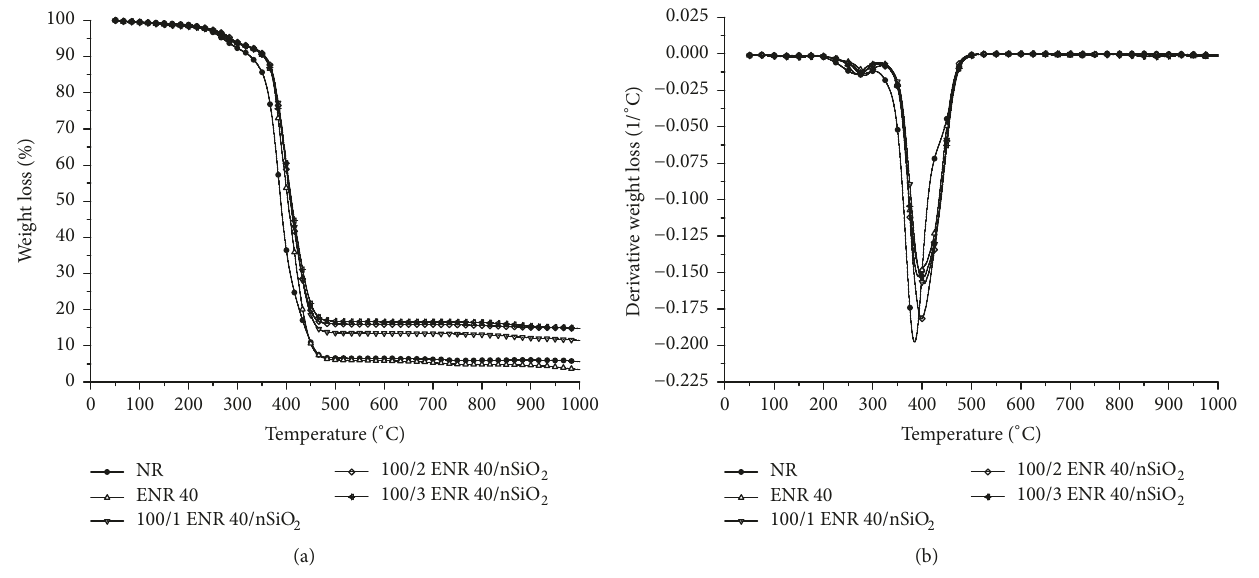
Figure 7: (a) TGA and (b) DTG thermograms of NR, ENR 40, and ENR 40/nSiO 2 nanocomposites. Table 3: Mechanical properties and % retention of NR, ENR 40, and ENR 40/nSiO 2